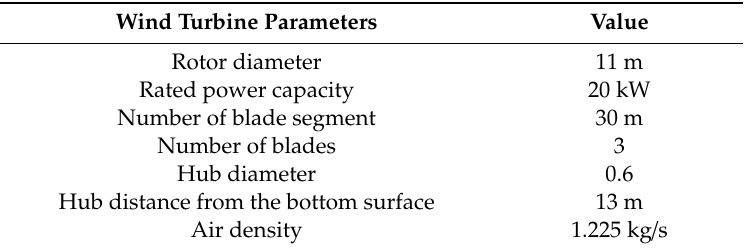
Table 3. Turbine